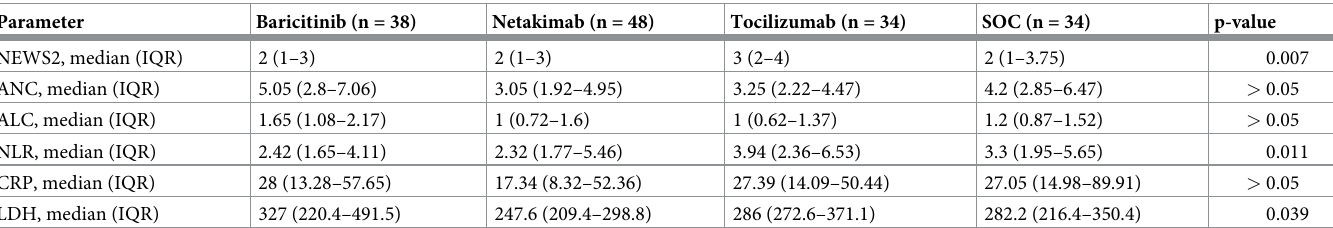
Table 2. Baseline clinical characteristics of